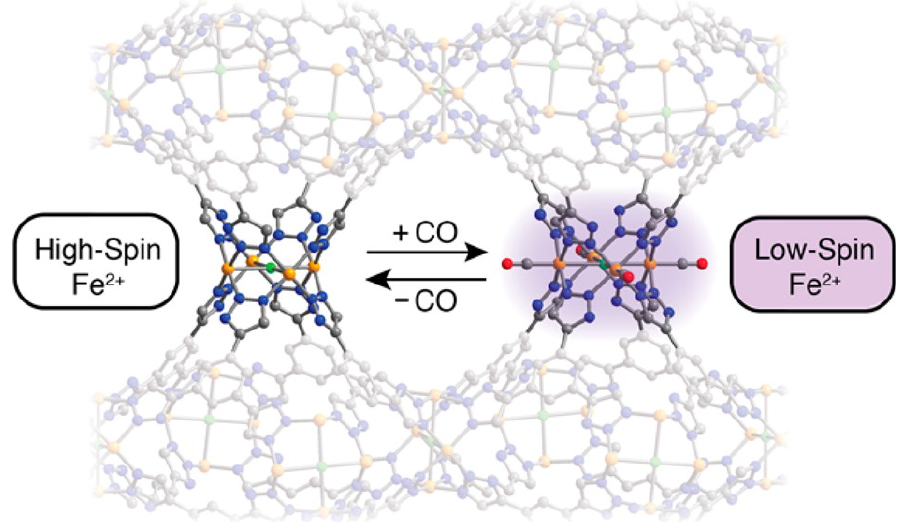
Figure 11. Reversible CO scavenging observed in MOF Fe 3 [(Fe 4 Cl) 3 (BTTri) 8 ] 2 ·18CH 3 OH (BTTri = 1,3,5-tris(1H-1,2,3-triazol-5-yl)benzene) driven by spin-state transition in Fe centers. Blue = N. Red = O. Yellow = Fe. Green = Cl. Grey = C. Adapted with permission from [119]; Published by American Chemical Society,